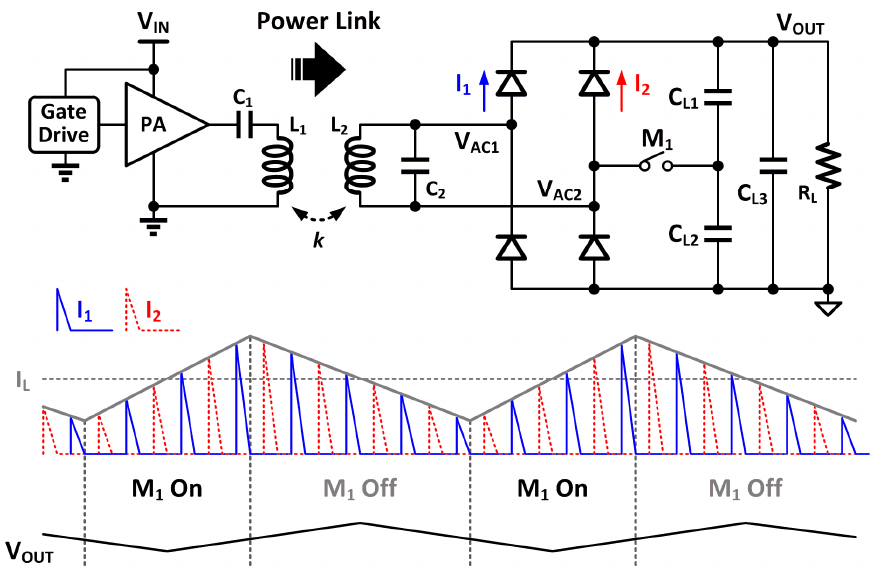
Figure 9. A WPT receiver with a 1X/2X regulating rectifier with pulse-width modulation [18].